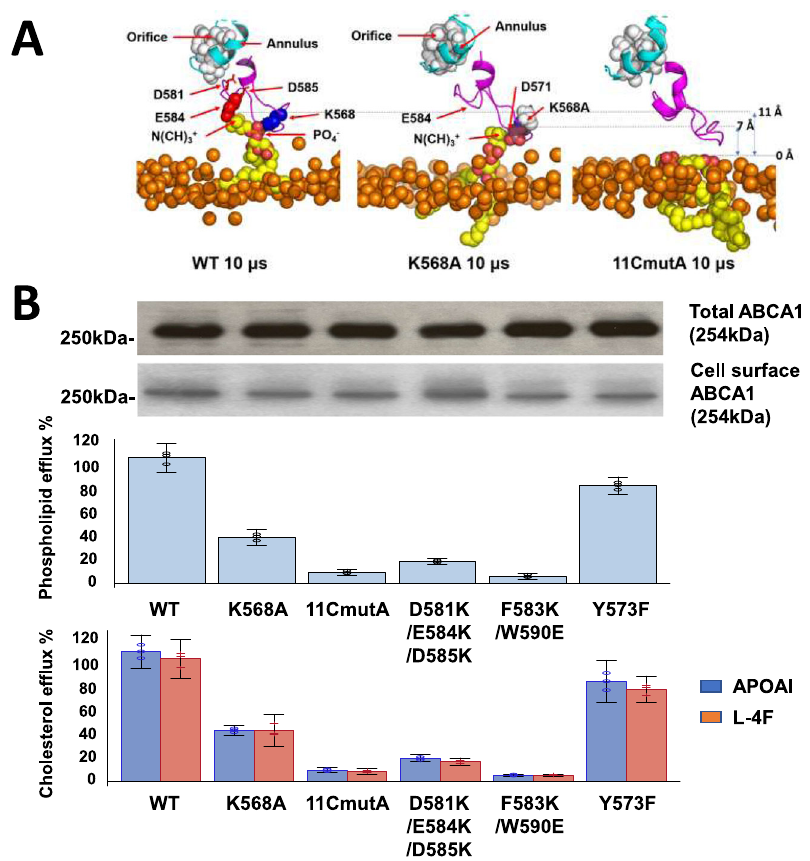
Fig. 3 | Charged amino acids in the gateway promote PL extraction and lipid exportbyABCA1.A ExtractionofPOPCmoleculesfromthemembranebilayerinto the gateway by wild-type and mutated ABCA1. Final frames of the three 10 μ sec CGMD simulations showing the gateway (magenta, cartoon), annulus (cyan, car- toon), and annulus ori fi ce (white, space- fi lling) for different ABCA1 monomers inserted into a POPC bilayer. The ABCA1 monomers are wild-type (WT, left panel), K568A(middlepanel),and11CmutA(mutationofall11chargedresiduestoalanine, right panel), respectively. The position of the upper monolayer surface in each image is shown by orange space- fi lling phosphorus atoms. The single POPC molecule extracted by the ABCA1 monomer of WT and K568A are shown in yellow (space- fi lling).The11CmutAmonomerfailedtoextractPOPC(yellow,space- fi lling).